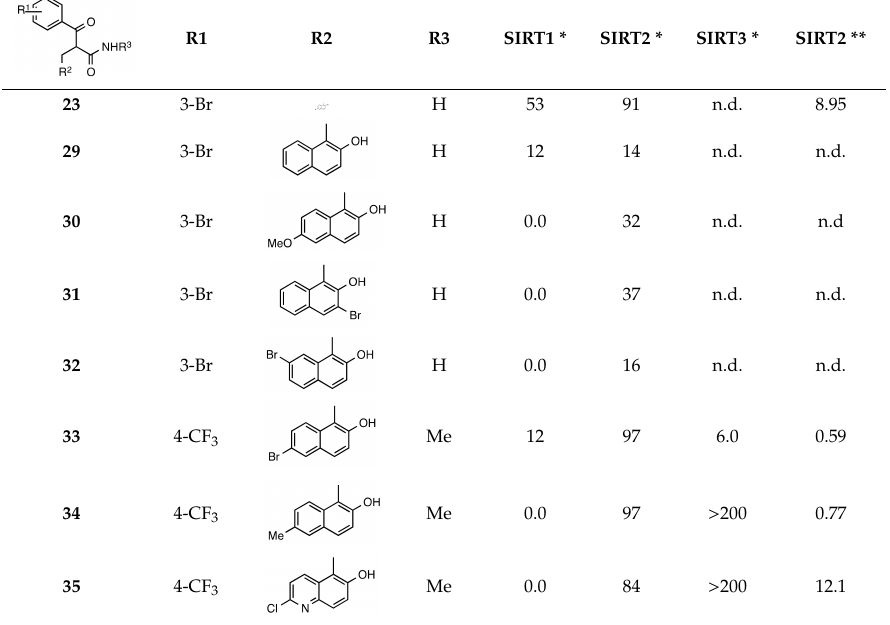
Table 2. Optimization of the naphthyl group (R 2 ).